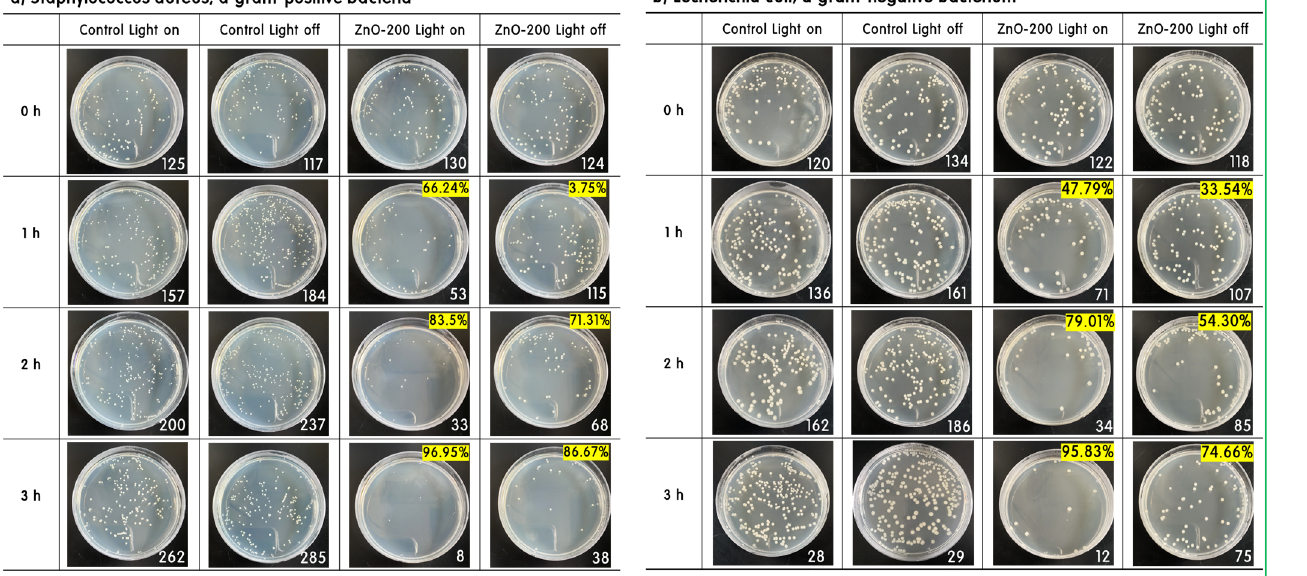
Figure 8. Sterilization capacity of ZnO-200 catalyst against ( a ) Staphylococcus aureus ; and ( b ) Escherichia coli .